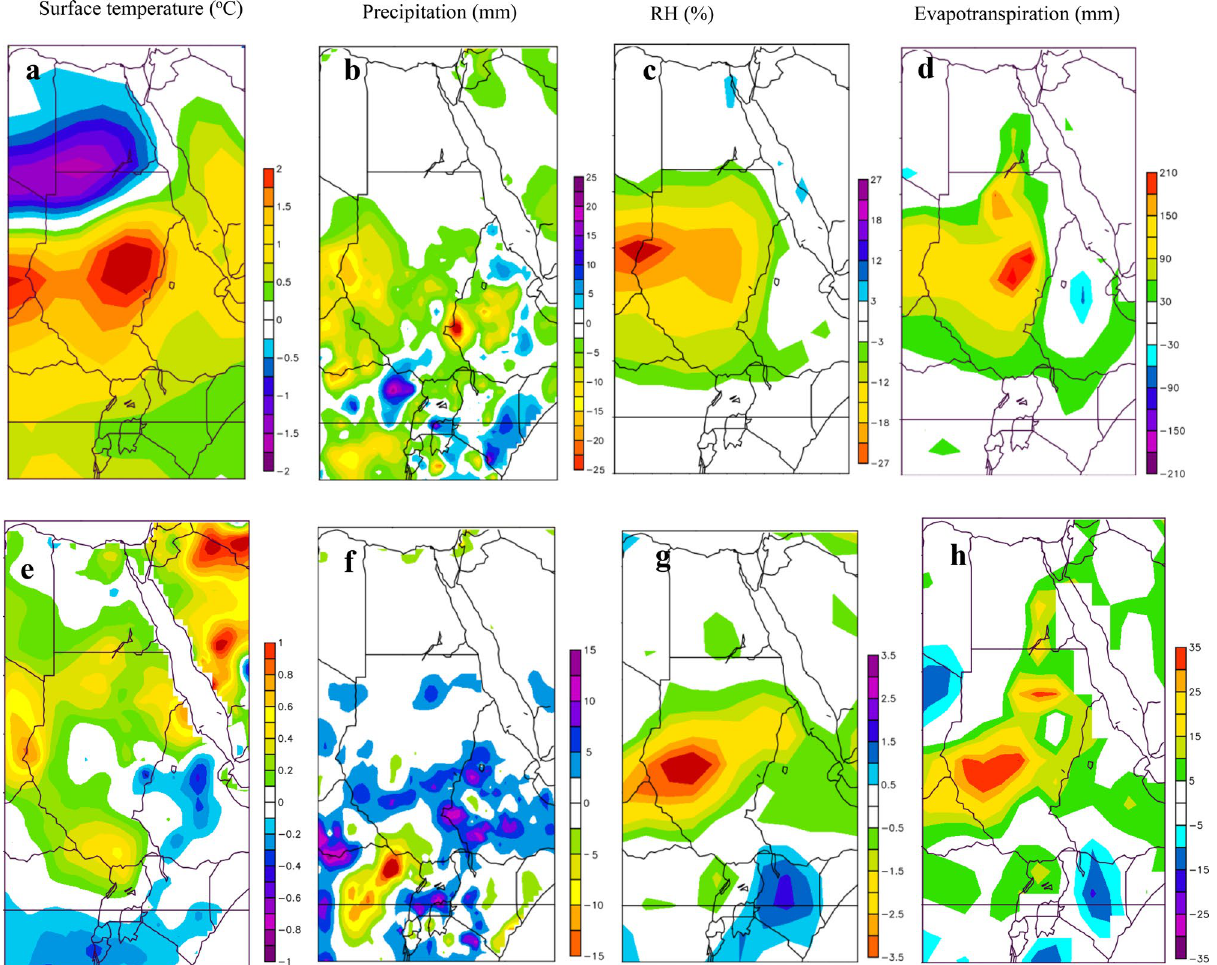
Figure 6. The effect of El Niño and La Niña events in the NRB shown by composite of NRB’ surface temperature associated with El Niño ( a ) and La Niña ( e ) episodes, composite of precipitation associated with El Niño ( b ) and La Niña ( f ) episodes, composite of relative humidity associated with El Niño ( c ) and La Niña ( g ) episodes, and composite of evapotranspiration associated with El Niño ( d ) and La Niña ( h ) episodes.The maps were generated with NCAR Command Language (NCL) Version 6.2.1 (http:// www. ncl. ucar. African precipitation, ENSO and IOD 26 , which shows positive correlation with ENSO and IOD. Figure 5f also shows a significant positive correlation between IOD and precipitation in Uganda, Kenya, Tanzania, Burundi, and Rwanda. The negative influence of IOD on Ethiopian’s precipitation was also shown by Kotecha and Barnston 28 . In contrast to El Niño induced impacts on the NRB’s RH and AET over the past 70 years, our findings show that IOD have a positive effect on NRB’s RH (increase) i.e., lower AET (Fig. 5g,h). This is evident in the statistically significant positive (negative) correlation between IOD and RH over Egypt and northern parts of Sudan (Ethio- pian highlands, Kenya, and Tanzania). In other words, the relationship between NRB’s RH and AET and IOD shows an opposite pattern to their relationship with El Niño. Figure 5g,h also shows that IOD reduced El Niño negative influence on RH over Egypt and northern parts of Sudan and intensified the influence over Ethiopian highlands, Kenya, and Tanzania resulting in higher AET over these countries. We have analyzed composites of separate phases of ENSO and IOD to identify the distinct features of each phase in in NRB annual surface temperature, precipitation, RH, and evapotranspiration. First, pure El Niño and La Niña events were identified and were compared to non-ENSO/IOD events following the approach adopted in Meyers et al. 33 . Then, NRB surface temperature, precipitation, RH, and evapotranspiration during each phase were averaged and subtracted from the average of the nonevents to form the composite. The same approach was followed to form the composite of positive and negative phases of IOD. Differences between El Niño and La Niña composites show that the impacts of El Niño are larger than La Niño in the NRB (Fig. 6). For instance, the surface temperature anomaly composites of pure El Niño events (Fig. 6a) show higher than normal surface temperature over the upper part of the NRB (0.5–2 °C), and lower than normal downstream (mainly over Egypt). The precipitation anomaly composites of pure El Niño events in Fig. 6b show below average precipitation over the upper part of the NRB (− 5 to − 25 mm). The highest increase (decrease) in surface temperature (precipita- tion) anomaly during pure El Niño events can be seen over lowland of Ethiopia, Sudan, Uganda, Rwanda, and